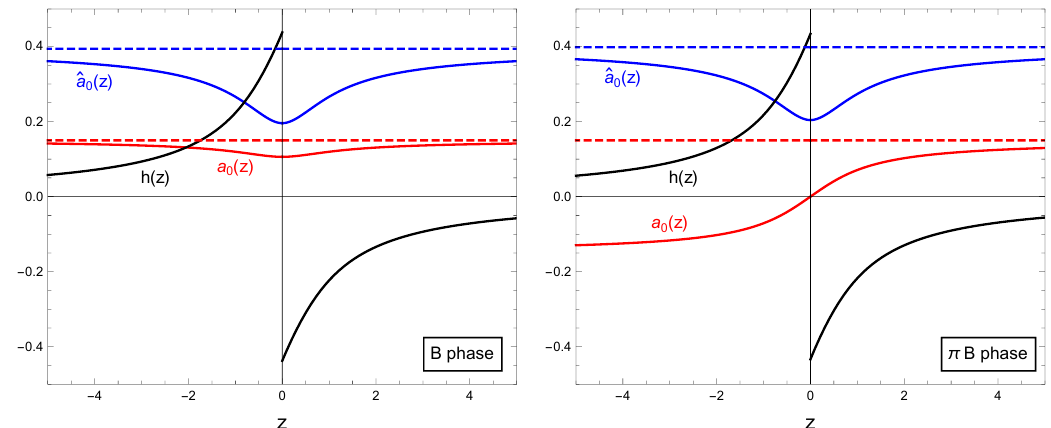
Figure 1: Profiles of the functions h ( z ) (black, non-abelian spatial component of the gauge ( z ) (blue, abelian temporal gauge field) and a ( z ) (red, non-abelian temporal gauge field), ˆ a 0 0 = 0.4 and field). The chemical potentials act as boundary conditions, here chosen to be µ B µ = 0.15, indicated by the dashed lines. The discontinuity in h ( z ) gives rise to a nonzero I ( z ) is even in z ( σ -type boundary conditions, pure baryon baryon number. In the left panel a 0 ( z ) is odd in z ( π -type boundary conditions, coexis- phase B), while in the right panel a 0 ) (cid:39) ( 0.08,0.02 ) and tence phase π B). The resulting baryon and isospin densities are ( n , n B I ( n ) (cid:39) ( 0.07,0.05 ) respectively. In both panels we have used λ = , n B I